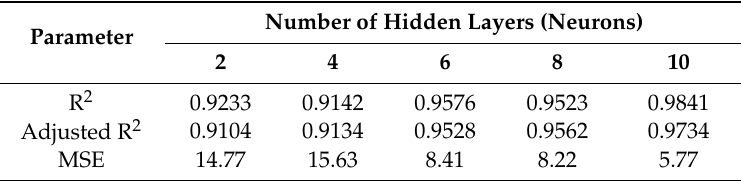
Table 5. Performance evaluation in the selection of the